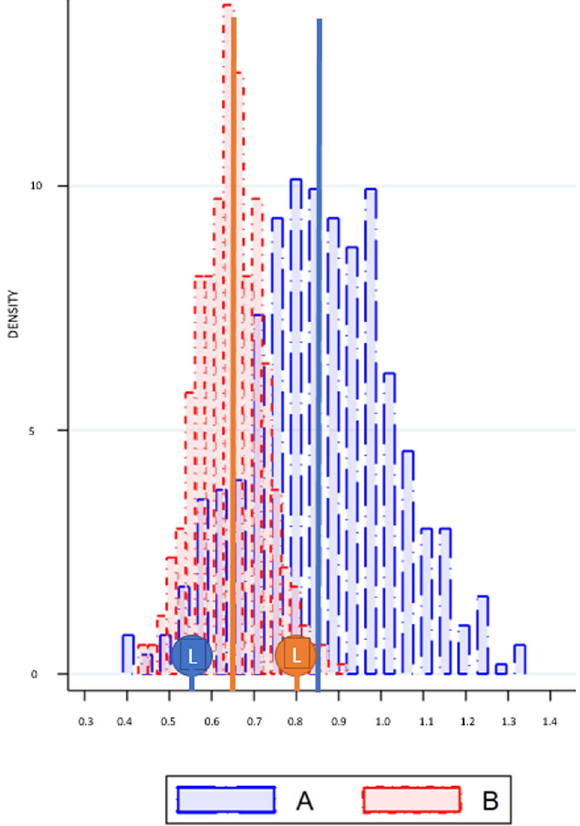
Fig. 1 Heterogeneous, average, and individual treatment effects. Hypothetical results of a randomized controlled fi eld-experiment. The outcome distributions show the resulted outcomes after being treated with treatment A (blue) or B (red). The lollypops show the outcomes after being treated with treatment A (blue) or B (red) for one particular person